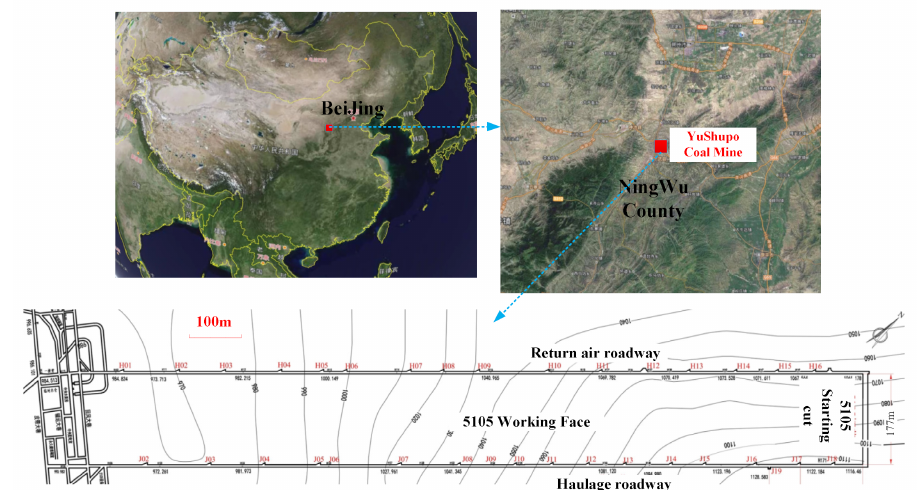
Figure 4. Location of Yushupo Coal Mine [27].